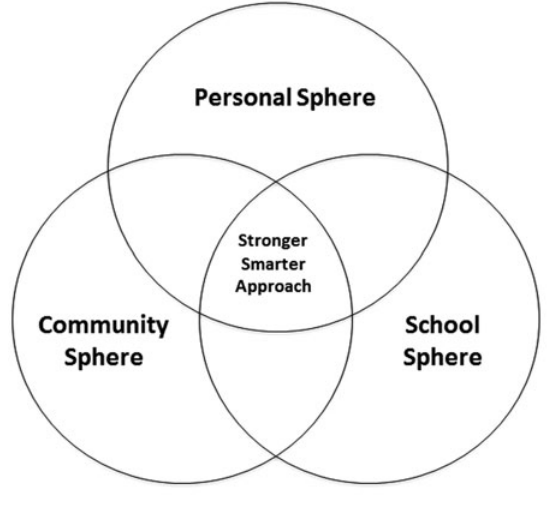
FIGURE 1 Spheres of the stronger smarter